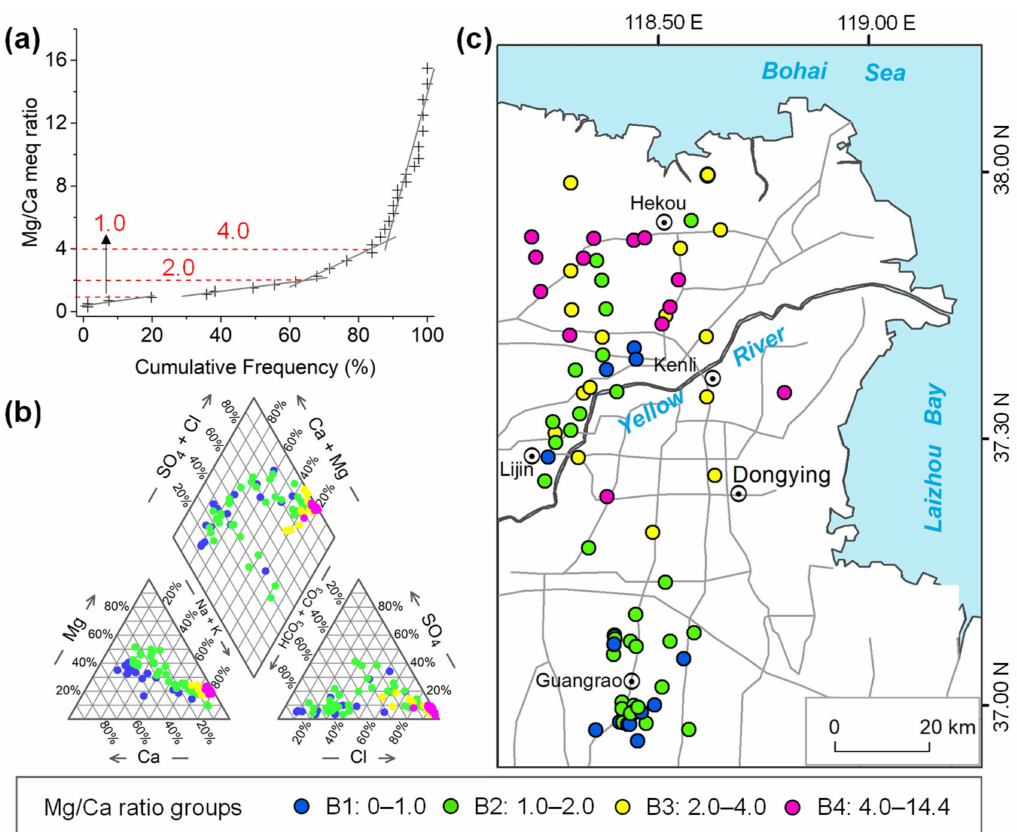
Figure 6. Cumulative frequency distribution curve for Mg/Ca ratios ( a ); representation of groupings on a Piper diagram ( b ); and distribution of Mg/Ca groups in the study area ( c